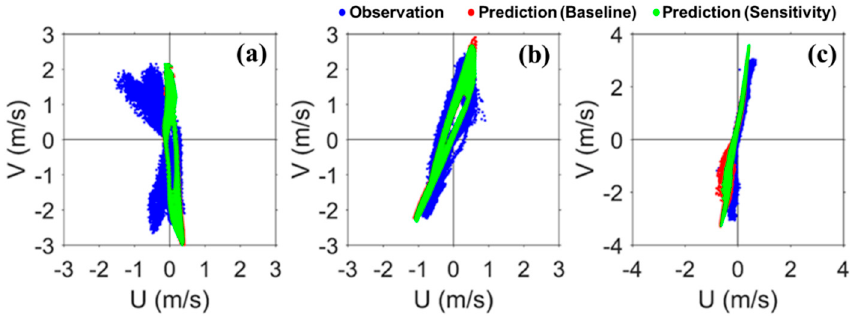
Figure 5. Scatterplots comparisons of U and V velocity components for model-predicted depth-averaged tidal currents (including both the baseline calibration run and the sensitivity test run with refined model grid) and NOAA observations at three ADCP locations in the Foreland region ( a ) COI0501; ( b ) COI0502; ( c ) COI0503. The plots were generated from depth-averaged velocity time series for both model predictions and field observations.